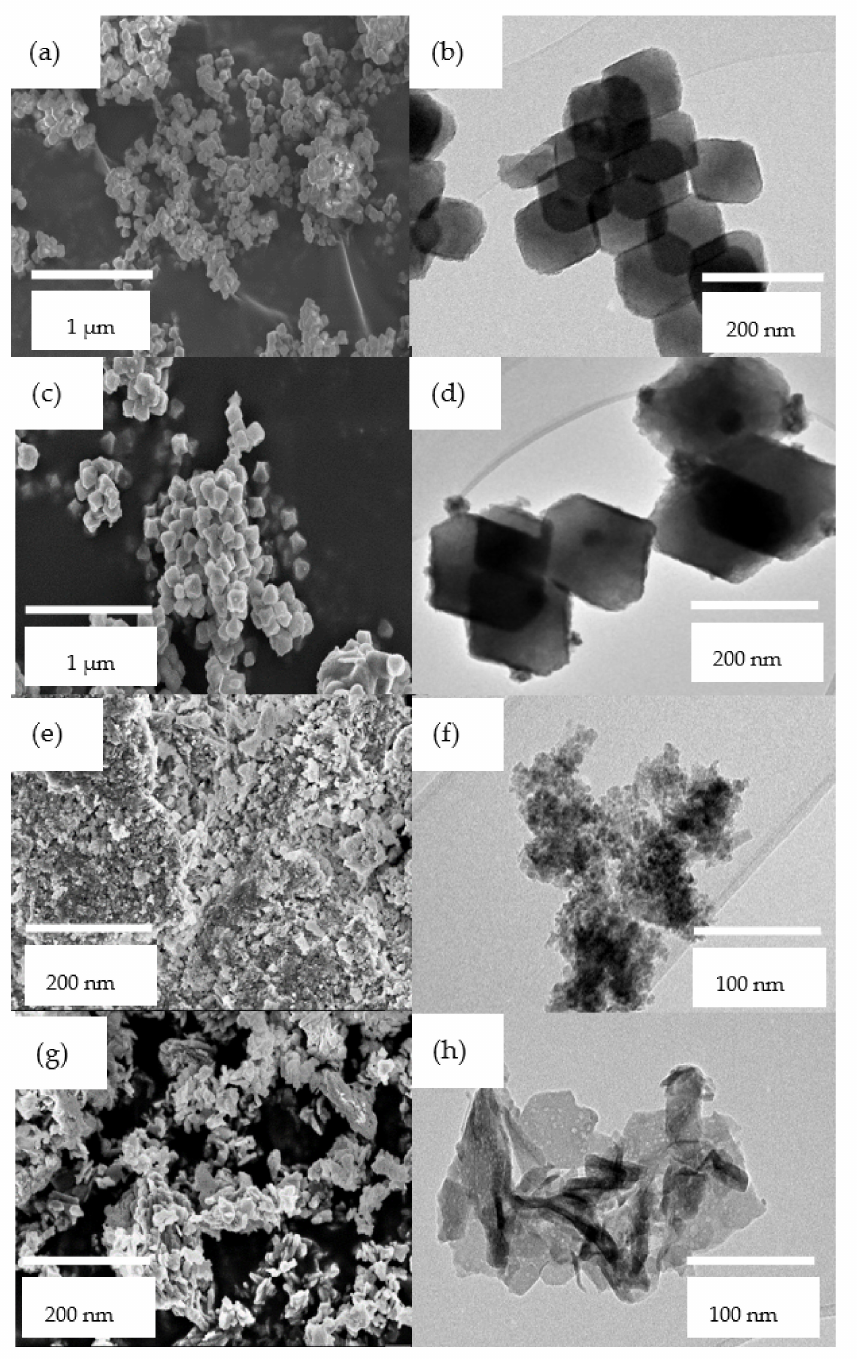
Figure 3. SEM and TEM images of ( a , b ) UiO-66; ( c , d ) Cu/ZnO/UiO-66; ( e , f ) commercial catalyst; and ( g , h ) CuO/ZnO/Al 2 O 3 /MgO catalyst. The images were taken at different magnifications. The TEM images of the pristine UiO-66 and Cu/ZnO/UiO-66 catalyst shown in Figure 3b,d corroborate the octahedral shape of UiO-66 particles seen in Figure 3a,b. Fur- thermore, on the surface of the UiO-66 particles in the Cu/ZnO/UiO-66 catalyst, small spherical nanoparticles can be seen which are indicative of CuO/ZnO nanoparticles [4,28]. These nanoparticles are well dispersed on the surface of UiO-66 particles as indicated